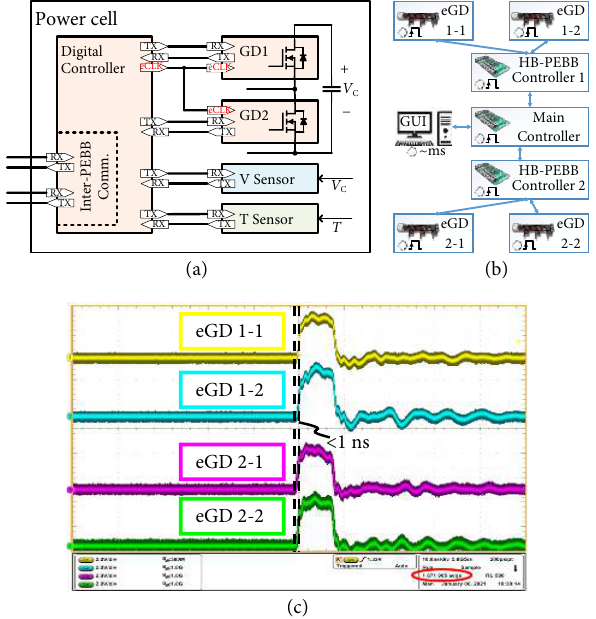
Fig. 10 (a) Inside-PEBB communication layer. (b) Testbed for synchroniza- tion verification. (c) Synchronization test waveform for four eGDs.